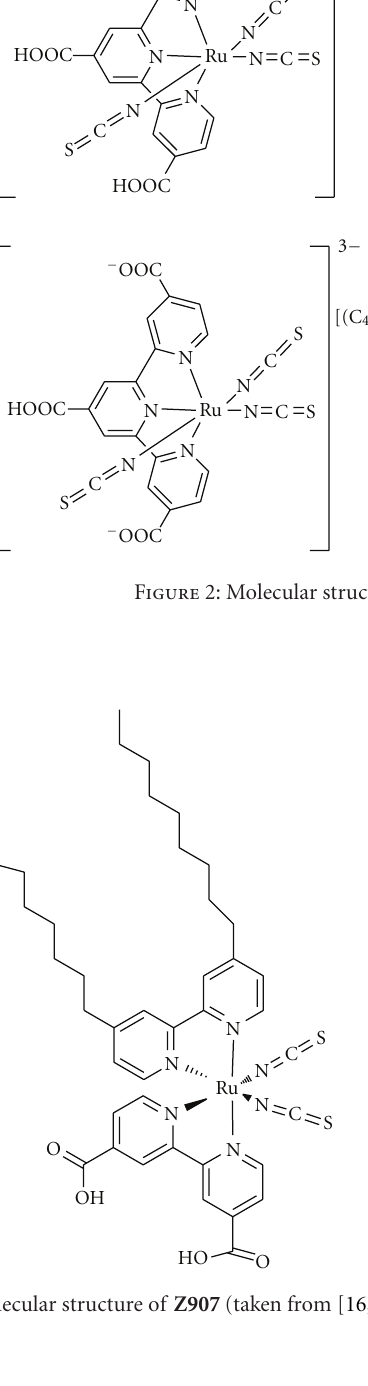
employing a new binary ionic liquid electrolyte composed of 1-propyl-3-methylimidazolium iodide and 1-ethyl-3- methylimidazolium tricyanomethanide in conjunction with the amphiphilic ruthenium complex NaRu(4-carboxylic acid-4 (cid:3) -carboxylate)(4,4 (cid:3) -dinonyl-2,2 (cid:3) -bipyridine)(NCS) 2 , coded as Z-907Na [18]. This heteroleptic Z-907Na